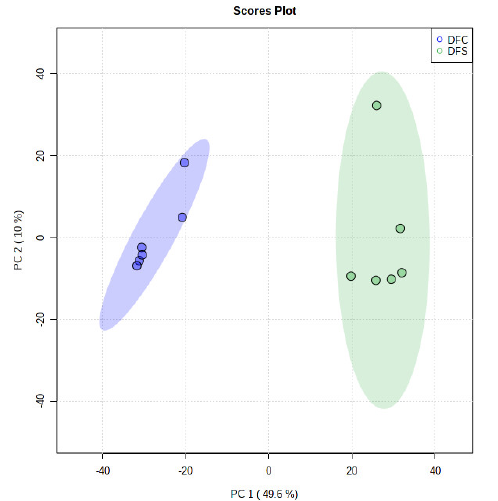
Figure 3. PCA scores plot in unsupervised analysis. PC1 versus PC2 showing the discrimination of DFC and DFS growing in different culture media.